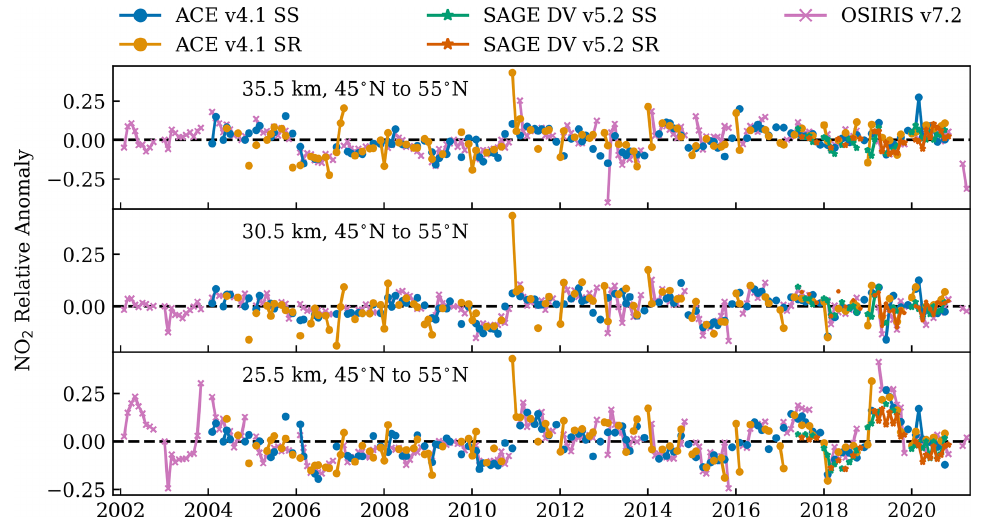
Figure A3. Anomaly time series comparing OSIRIS v7.2 to ACE v4.1 and SAGE III/ISS v5.2 DV for three altitudes at Northern Hemisphere